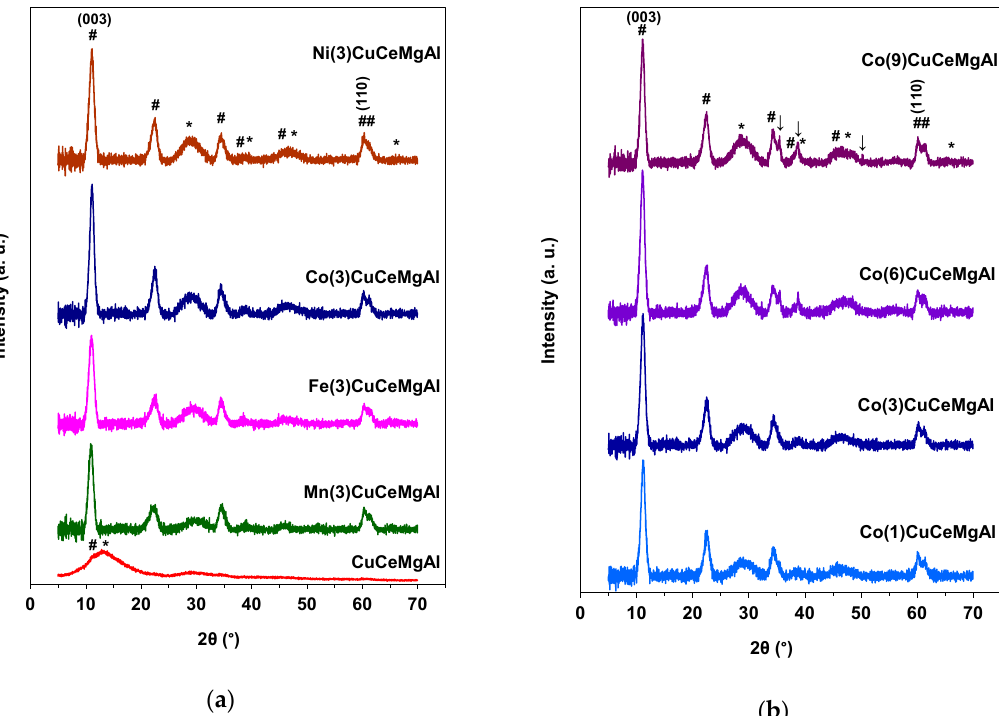
Figure 1. XRD patterns of ( a ) CuCeMgAl and M(3)CuCeMgAl, and ( b ) Co(x)CuCeMgAl LDH precursors. Symbols: #—LDH phase, ⋆ —boehmite (AlOOH) phase, ↓ —CuO tenorite.